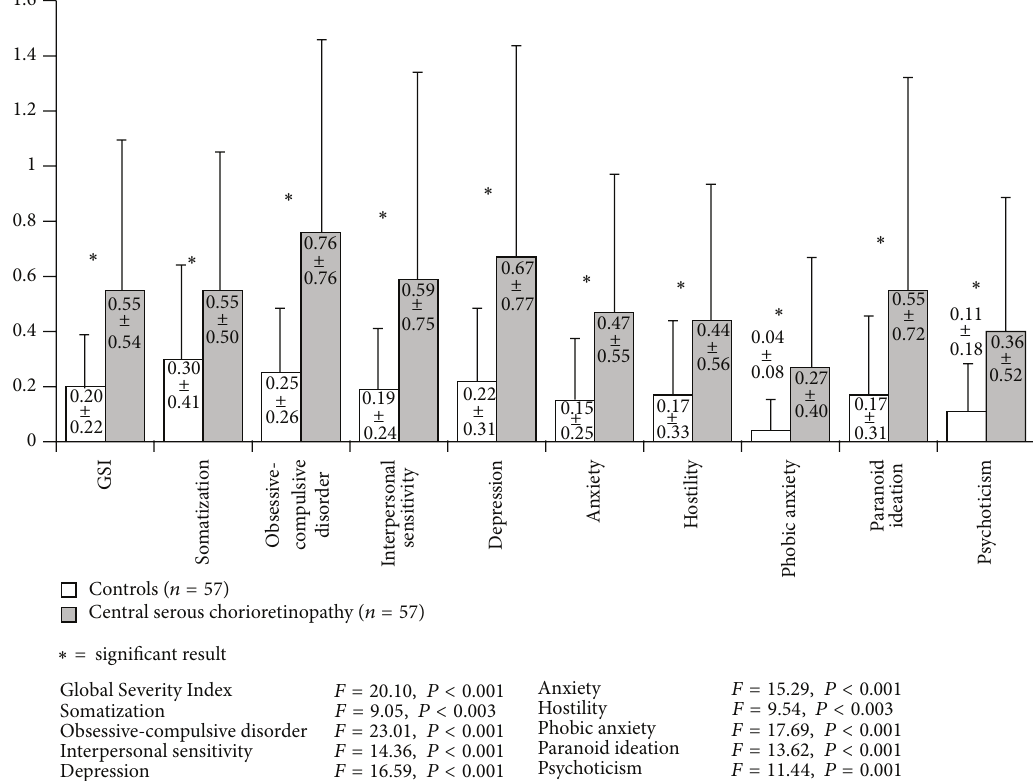
Figure 1: Showing heightened emotional distress and psychopathology, CSC patients scored significantly higher on all nine SCL-90-R symptom dimensions and the Global Severity Index compared to healthy controls.